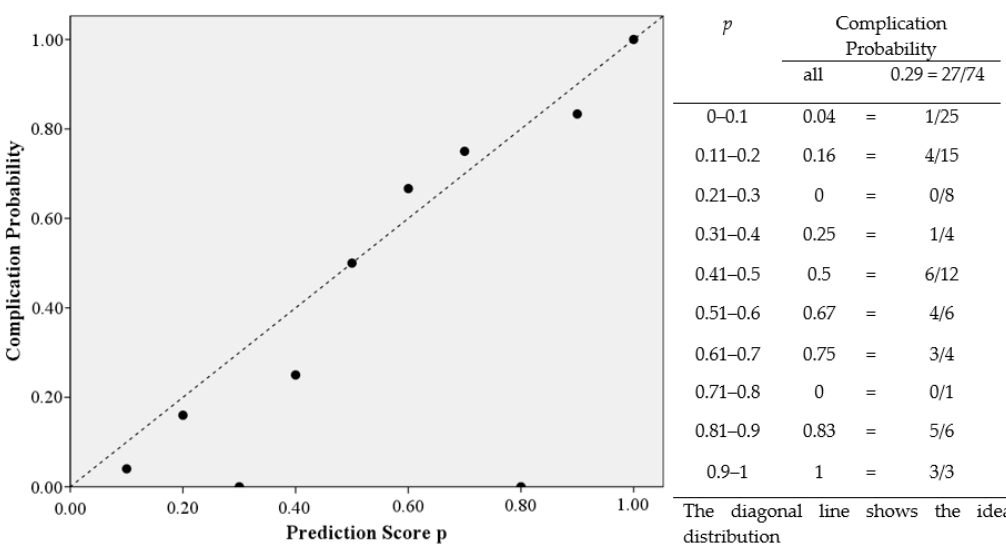
Figure 2. Complication Probability depending on the Prediction Score p .